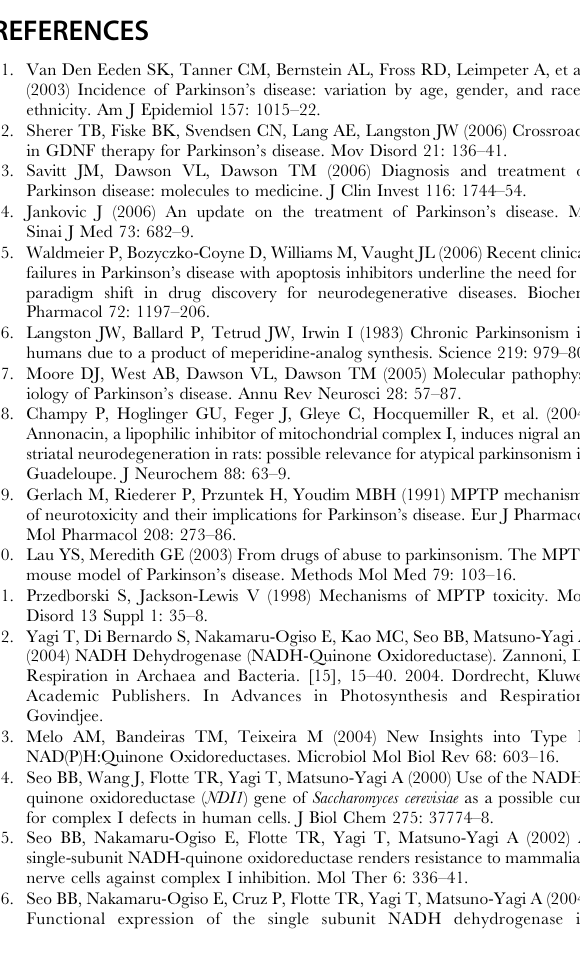
Figure S1 Expression of the Ndi1 protein in dopaminergic neurons of the substantia nigra (SN) of rat brain and its localization to mitochondria. Recombinant adeno-associated virus (serotype 5) carrying the NDI1 gene was stereotaxically injected to the right SN. Coronal sections at the level of SN were subjected to immunohistochemical staining. (A, B) Double-staining of a section with antibody against Ndi1 (A) and tyrosine hydroxylase (TH) (B) showing the expressed Ndi1 throughout SN neurons. Scale bar is 500 m m. (C–E) Confocal microscopy images of a SN neuron double-stained with antibody to Ndi1 (C) and the a subunit of F1- ATPase (D). Localization of Ndi1 to mitochondria is clearly seen in the merged image (E). Scale bar is 8 m m. Figure S2 Representative images of immunohistochemical staining of coronal sections at the level of striatum with antibody against TH. The staining intensity for TH from four groups of rats was statistically analyzed and the results were presented in Figure 2C. Found at: doi:10.1371/journal.pone.0001433.s002 (4.46 MB TIF) Movie S1 3D images of a SN neuron double-stained with antibody against Ndi1 (green) and the a subunit of